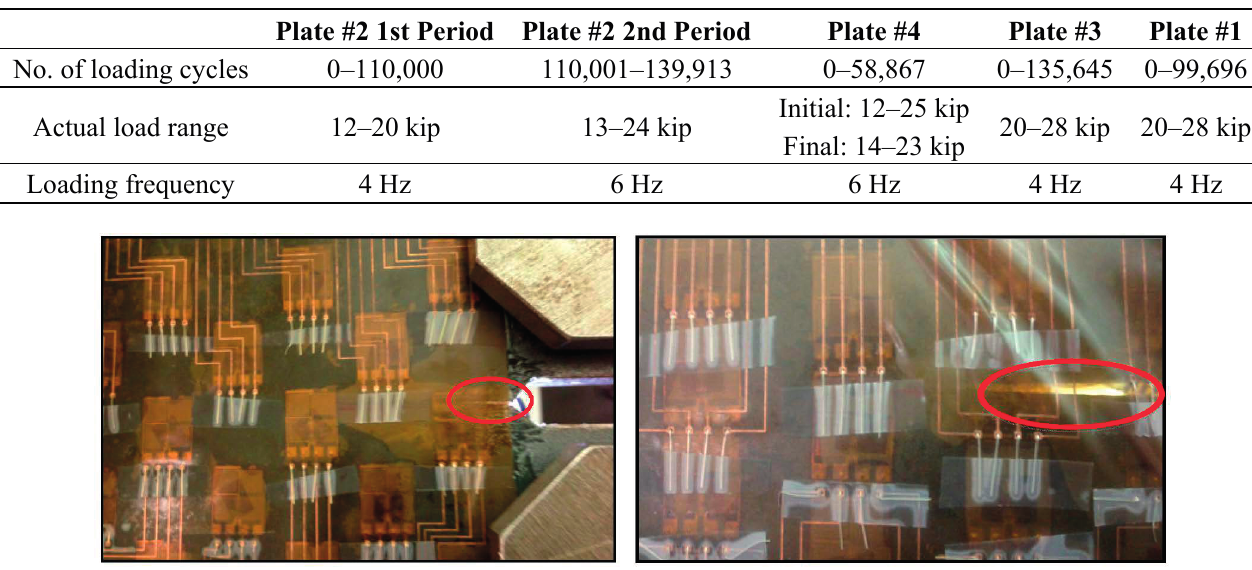
Table 1. Schedule of cyclic fatigue tests.